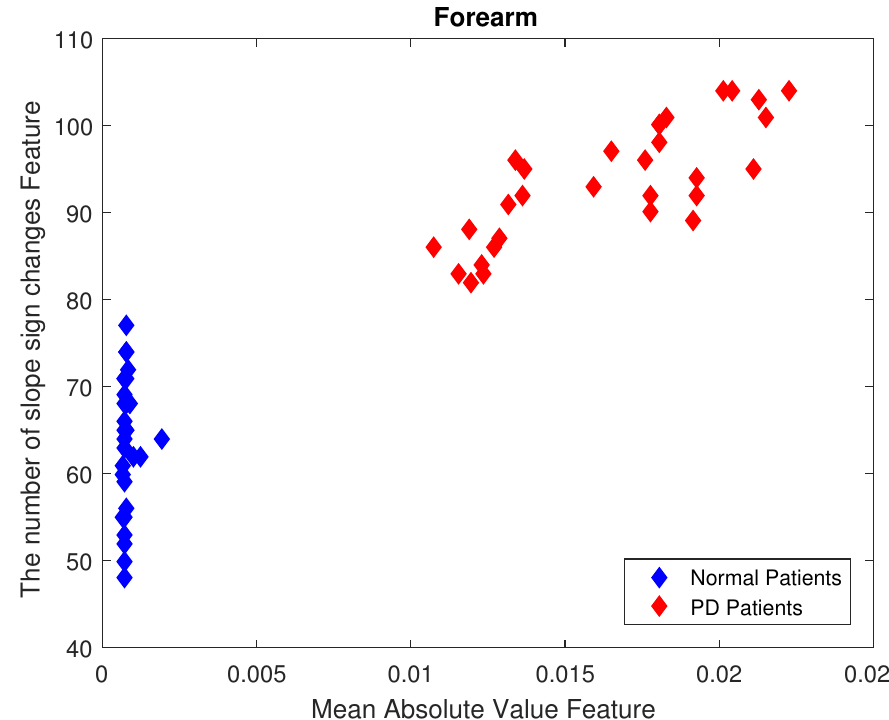
Figure 13. Two-dimensional scatter plot of SSC feature vs. MAV feature of forearm sEMG sensor for normal and PD